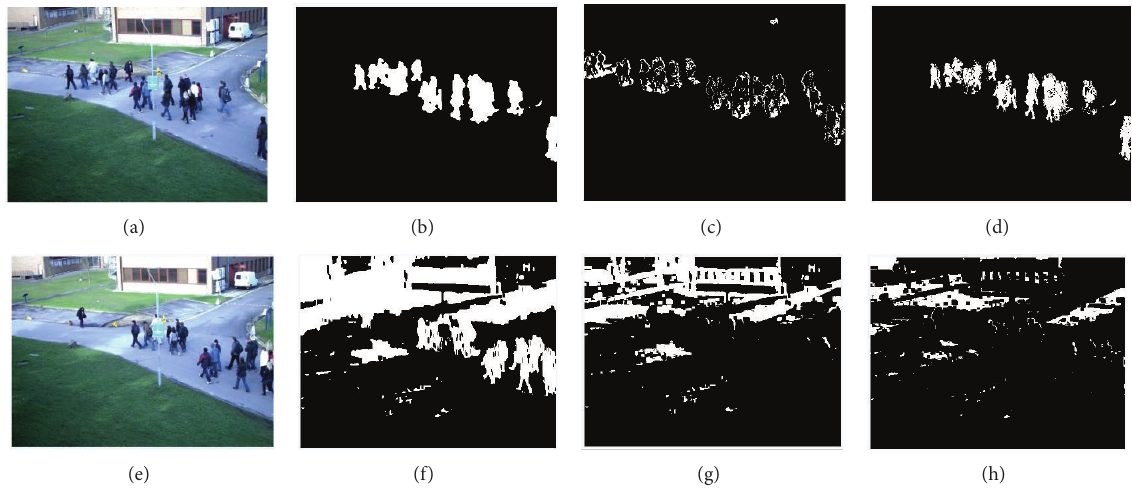
Figure 2: Two frames and the results with shadow removal. (a) and (e) are the frames (numbers 065 and 038) from the PETS2009 S1L1 with crowded people, (b) and (f) are the results of MoG method with frame difference, (c) and (g) are the detected shadows, and (d) and (h) are the results after removing the shadow.